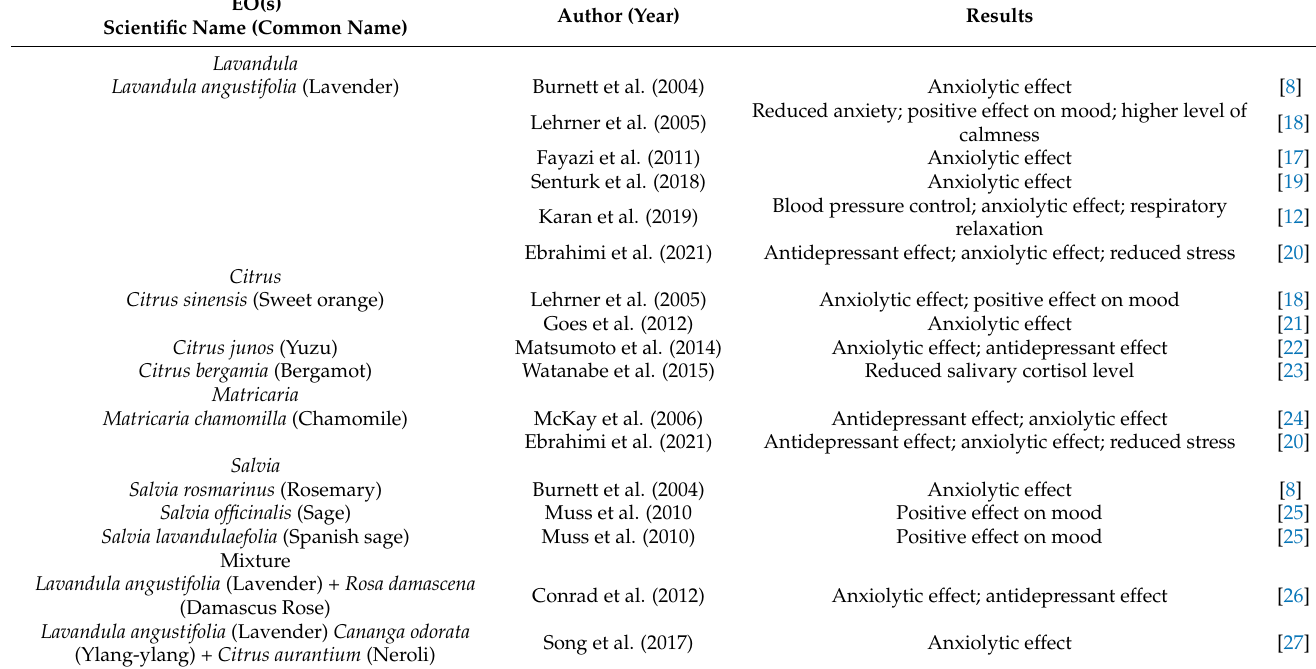
Table 1. Summary of clinical effects of EO inhalation on depression/anxiety disorders in human